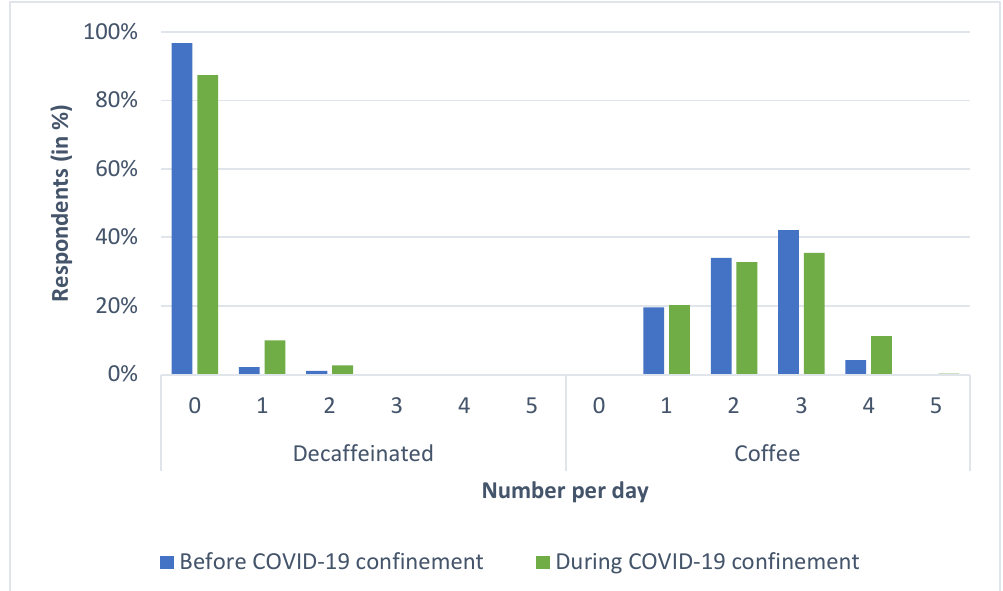
Figure 1. Decaffeinated ( left ) and coffee ( right ) change of consumption during COVID-19 confinement. Beverage consumption per day: 0 (without consumption), 1, 2, 3, 4, and 5 (five or more cups). The average consumption before COVID-19 confinement was 2.40 ± 0.84 cups and the average during COVID-19 consumption was 2.68 ± 0.878 cups. 29.8% of the respondents increased the number of cups of coffee they drank during COVID-19, and 12.5% decreased the